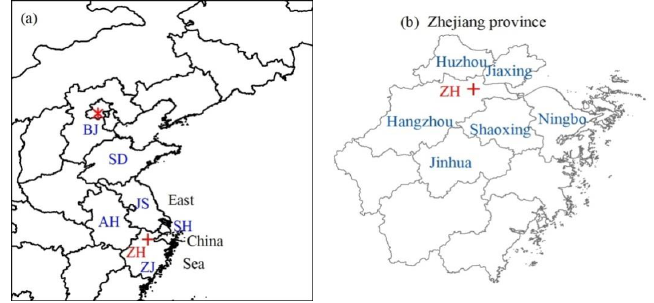
Figure 1. Location of the sampling site (Zhaohui, ZH) in Hangzhou, Zhejiang province (ZJ), China ( a ) and map of Zhejiang province ( b ). Locations of Beijing (BJ), Shangdong province (SD), Jiangsu province (JS), Anhui province (AH), and Shanghai (SH) are also